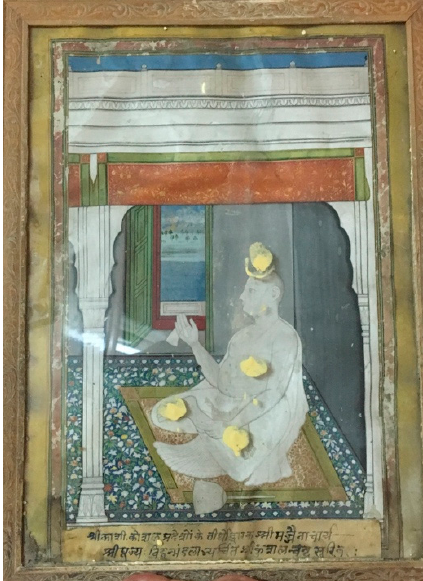
Figure 2. Nineteenth-century painting of Ku ś alacandras ū ri seated in the lecture hall of the Cint ā ma ṇ i P ā r ś van ā th Temple at R ā m Gh ā ṭ , with the door open to the Ganges behind him. This painting is